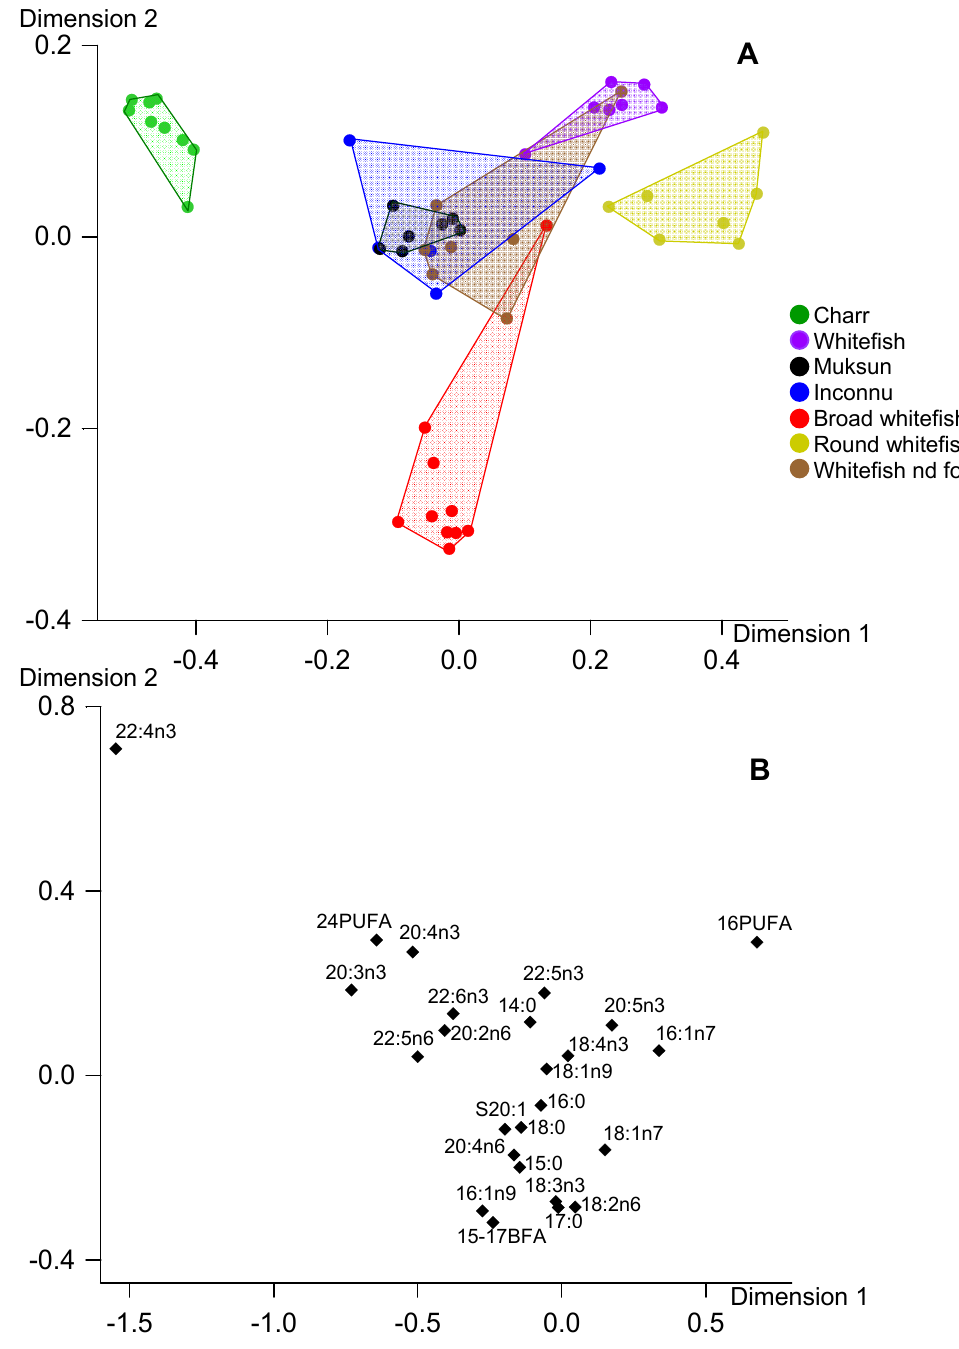
Figure 3. Canonical correspondence analysis of fatty acid percentages (% of FA sum) in triacylglycerols of muscles of seven fish species from arctic lakes (Siberia, Russia). A —individual variables, B —factor structure coe ffi cients for fatty acids. Dimension 1 and Dimension 2 represented 51.1% and 15.6% of inertia, respectively.